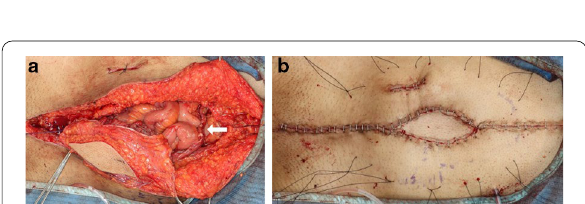
Fig. 6 Intraoperative photograph. Intraoperative image showing that the ALT flap was supercharged using the right gastroepiploic artery and vein (white arrow) ( a ). Postoperative picture showing the flap sutured to the defect with a healthy color ( b